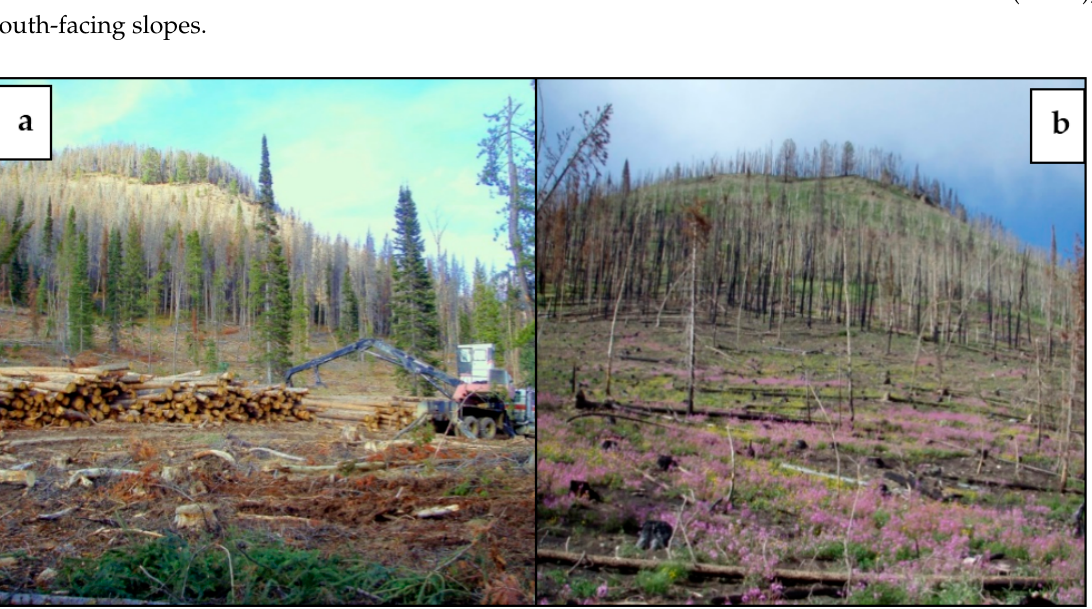
Figure 1. Paired photos taken ( a ) one year pre-fire (October 2009) and ( b ) one year post-fire (September 2011) within the Church’s Park Fire perimeter, near Fraser, Colorado. The photos are oriented northeast (20–30° azimuth) across an operational-scale Cut + Burn study site centered near 39°56 ′ 16.96 ″ N; 105°56 ′ 33.43 ″ W (See arrow in Figure 2). The log deck visible in photo ( a ) had been removed before the fire.